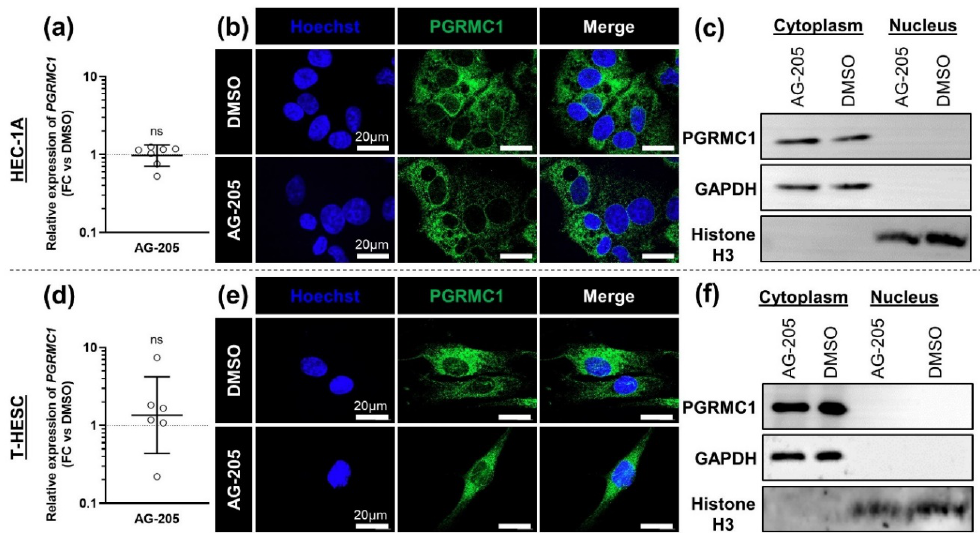
Figure 1. AG-205 does not modify expression of PGRMC1. Relative expression, immunolocalization and immunoblotting of PGRMC1 in HEC-1A ( a – c ) and T-HESC ( d – f ) cell lines treated with 15µM AG-205 or control DMSO during 32h. ( a , d ) Relative expression of PGRMC1 was measured by RT-qPCR, normalized, compared to corresponding DMSO controls and is presented as individual fold changes (FC) in log scale and as geometric mean with geometric SD ( n = 6–7). Statistical test: Wilcoxon paired test, not significant (ns). ( b , e ) The localization of PGRMC1 protein (in green) was assessed by immunocytofluorescence and nuclei were stained in blue ( n = 10–12). ( c , f ) For both culture conditions (AG-205 and DMSO), PGRMC1 (24 kDa) was immunoblotted in equal amounts of cytoplasmic biomaterial and in equal amounts of nuclear biomaterial ( n = 3). Immunoblotted histone H3 (17 kDa) and GAPDH (36 kDa) were used as loading controls for the nuclear and cytoplasmic fractions, respectively.